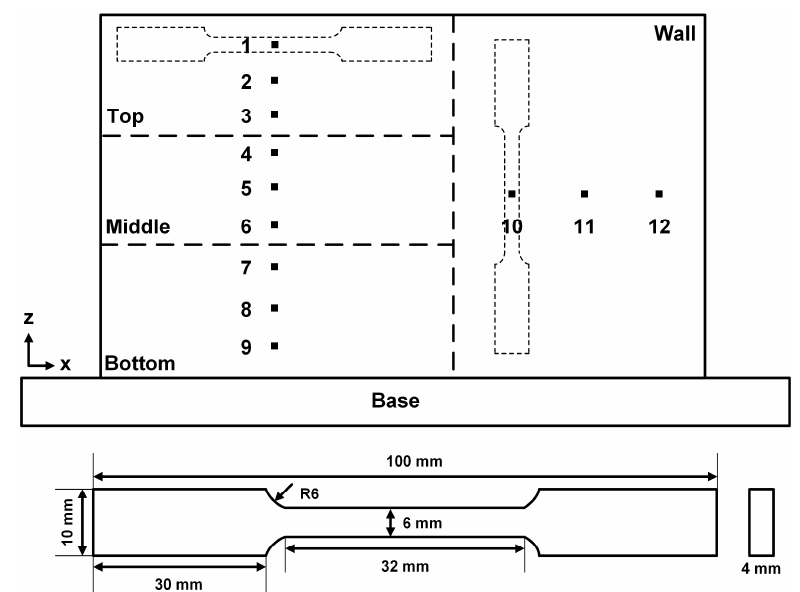
Figure 3. Schematic of the tensile test specimens extracted from the WAAM sample. Metals 2019 , 9 , 673